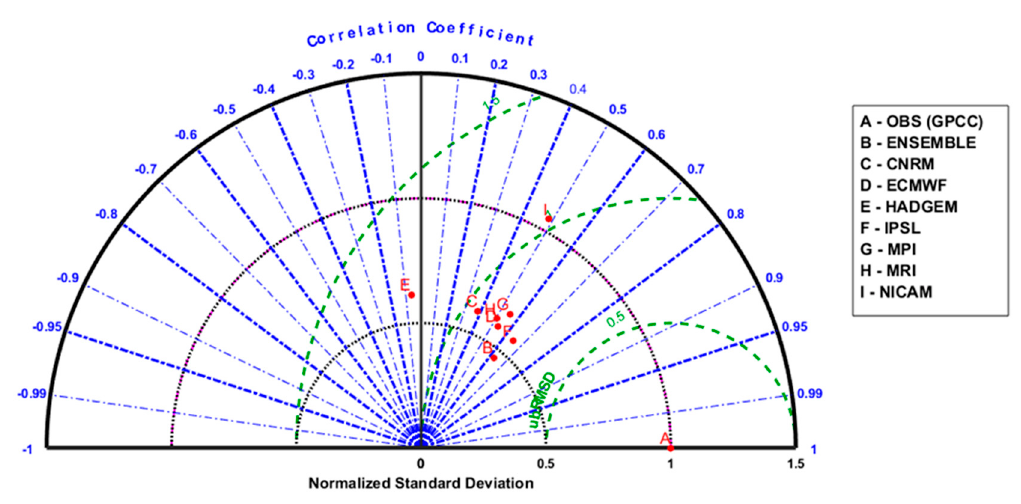
Figure 9. Taylor diagram of extreme precipitation (R95p) anomaly over West Africa.